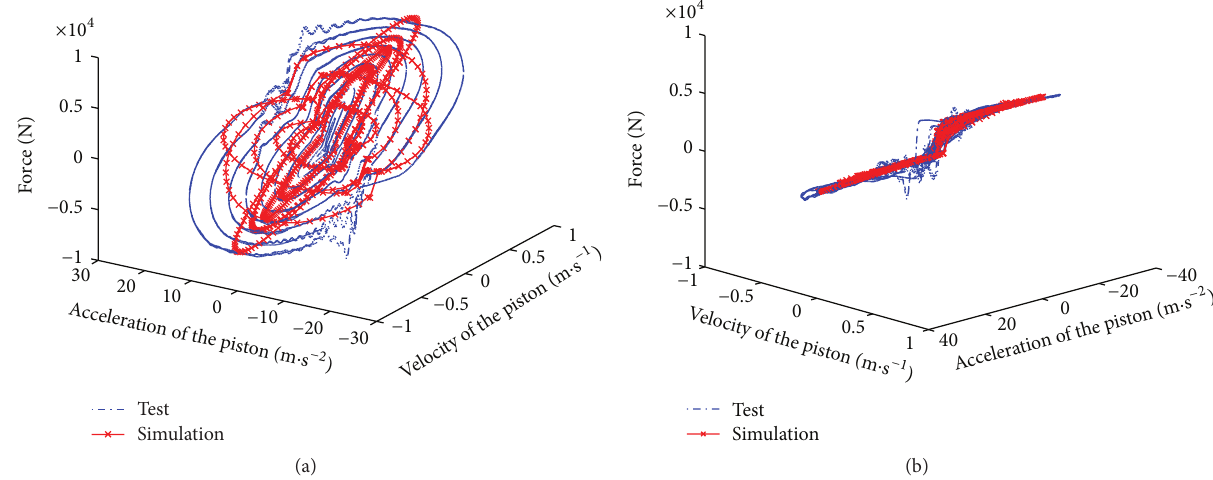
Figure 12: Three-dimensional comparisons under different excitation conditions: (a) first visual angle; (b) second visual